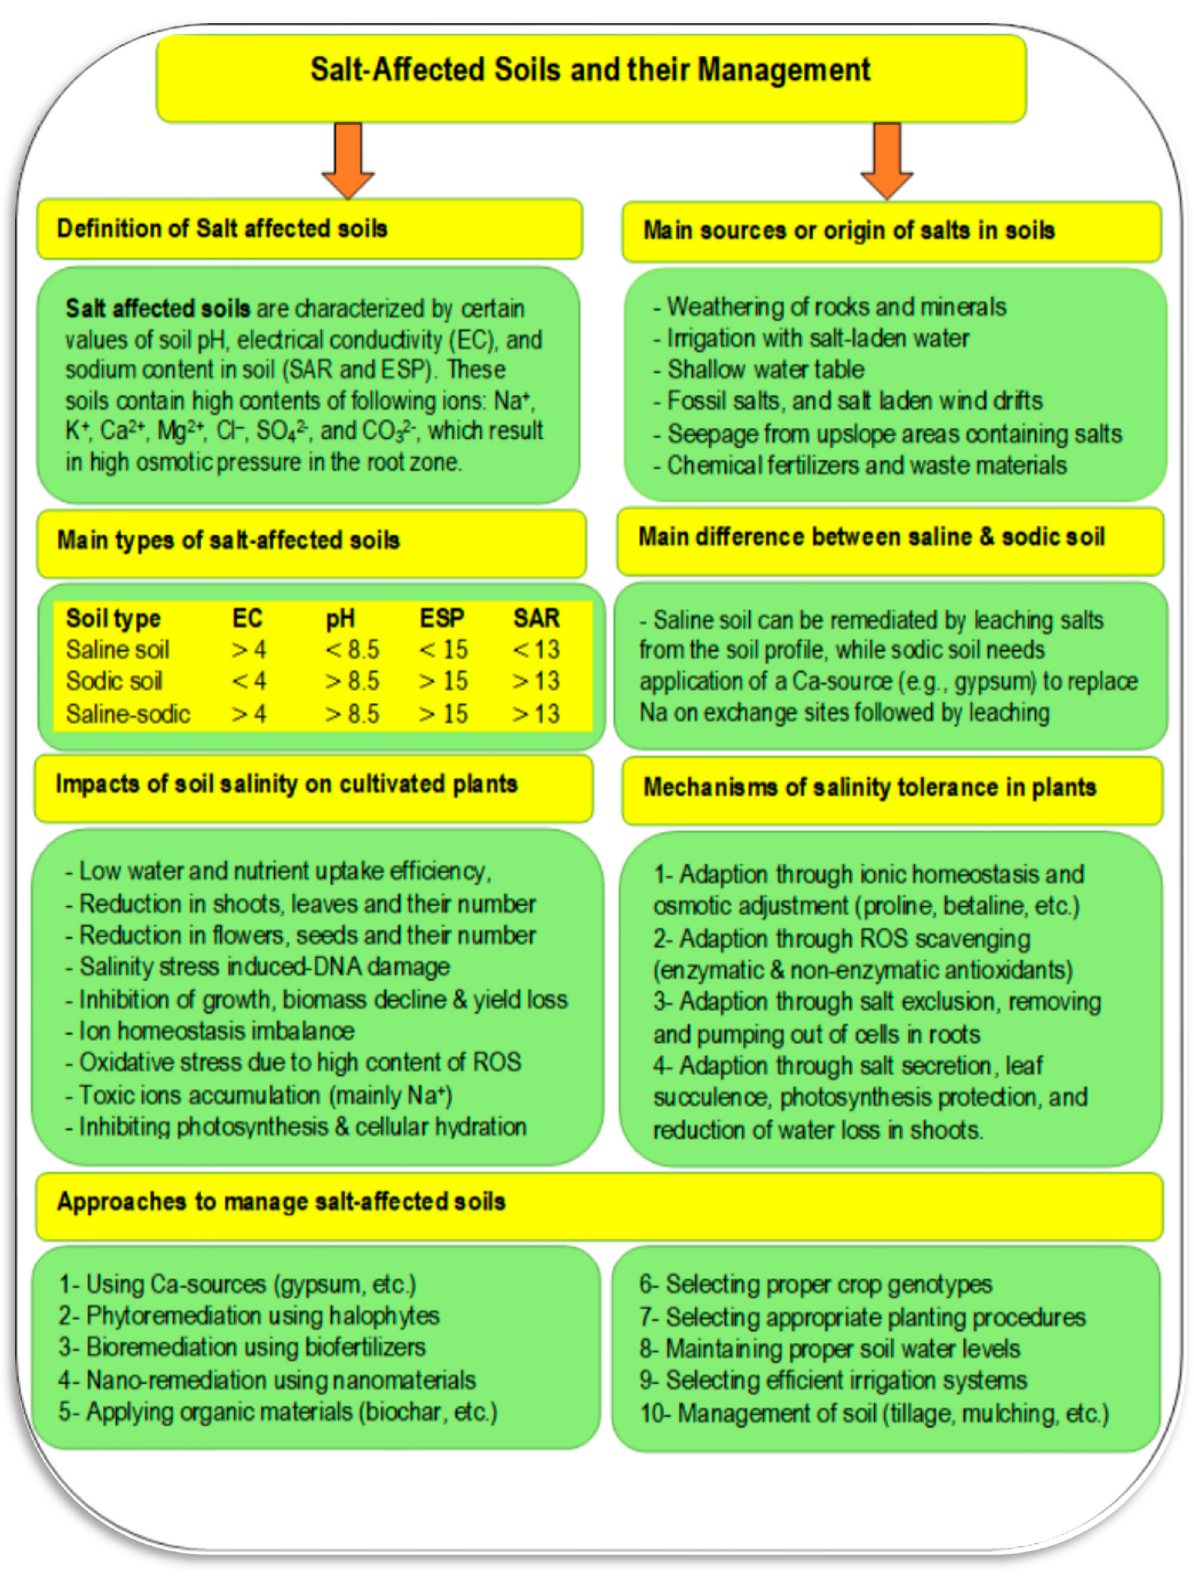
Figure 5. Definition of salt-affected soil, sources of salts, different impacts of soil salinity on cultivated plants, mechanism of salinity tolerance, and different management approaches (Sources: [52–55]).